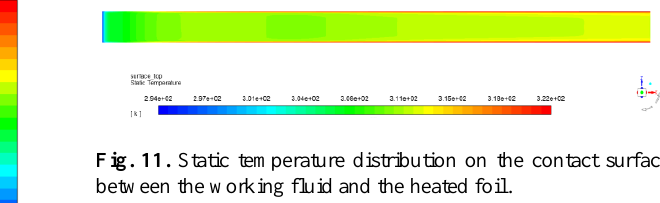
flow vary with different mesh densities.